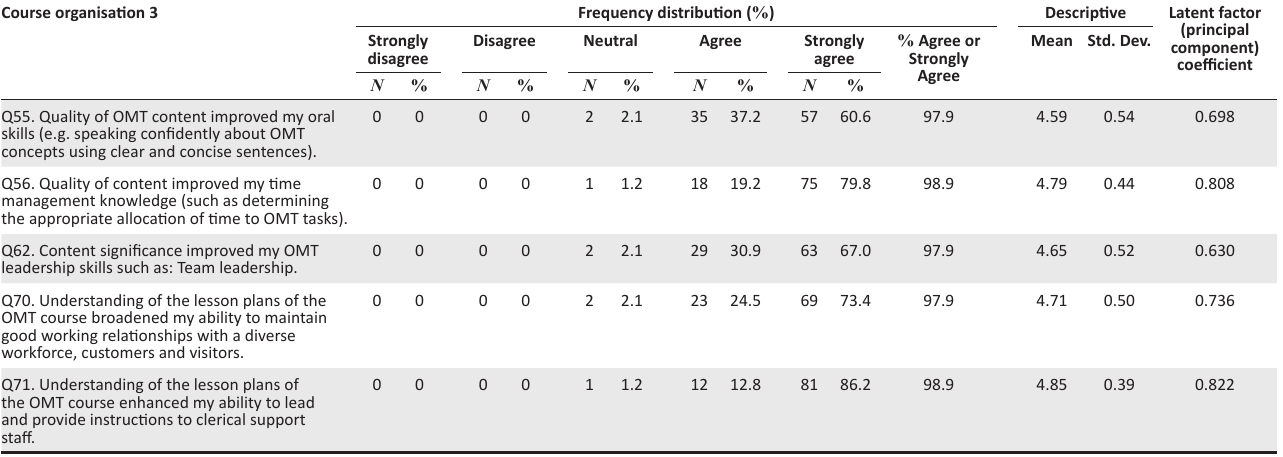
TABLE 10: Effect of course organisation